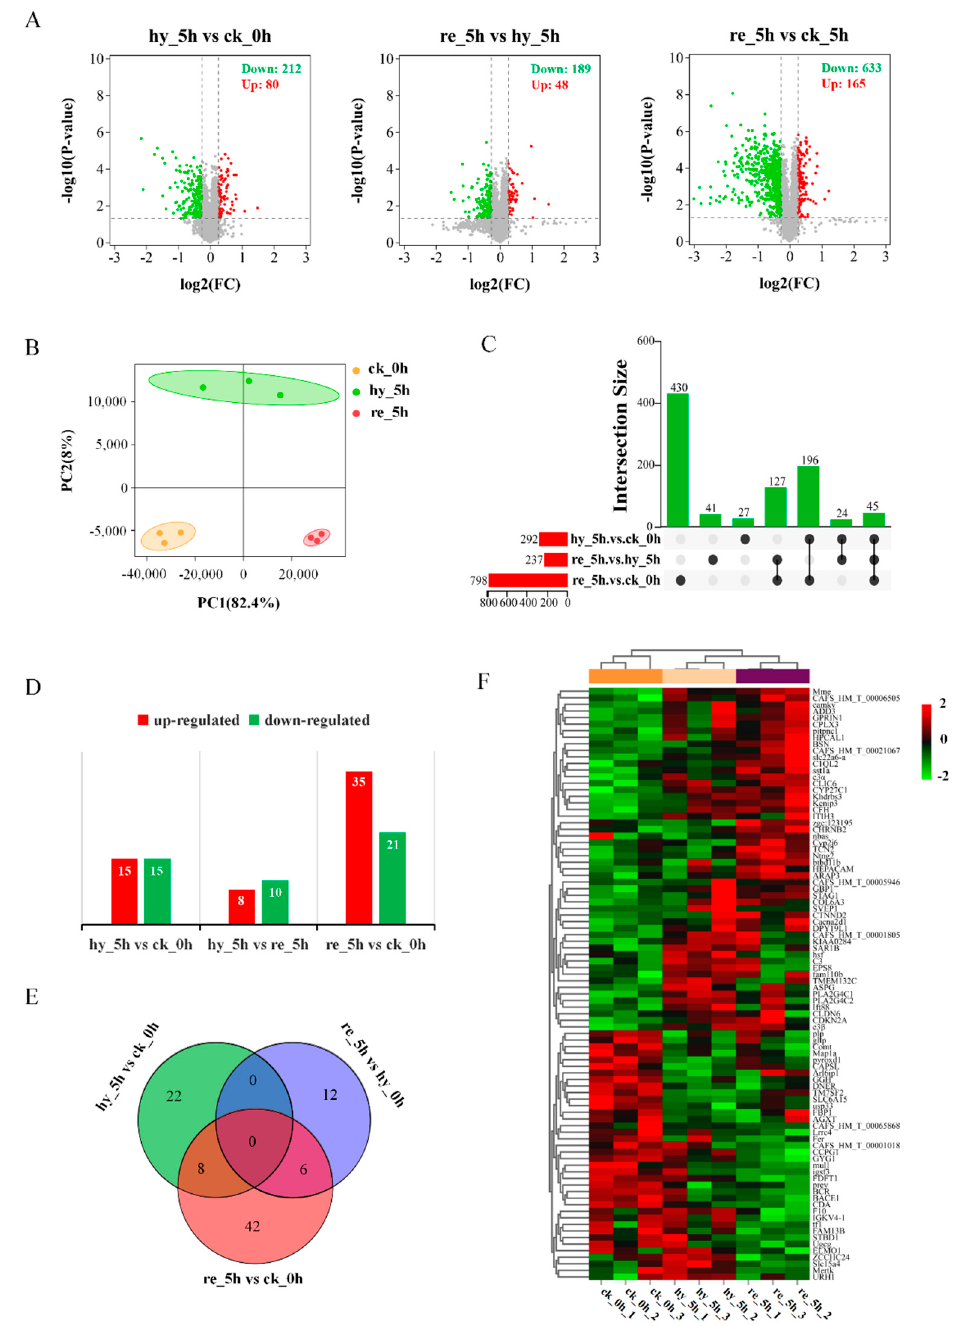
Figure 2. Differential protein expression analysis in the liver and brain among the control, hypoxia, and reoxygenation groups of juvenile silver carp: ( A ) volcano plots showing DAPs in pairwise comparisons in the liver; ( B ) principal coordinates analysis (PCoA) in the liver; ( C ) upset Venn plot for consistent DAPs in pairwise comparisons in the liver; ( D ) DAPs in pairwise comparisons in the brain; ( E ) Venn plot showing the common proteins shared in pairwise comparisons in the brain; ( F ) heat map displaying the relative expression of 90 DAPs in the brain. DAP, differentially abundant